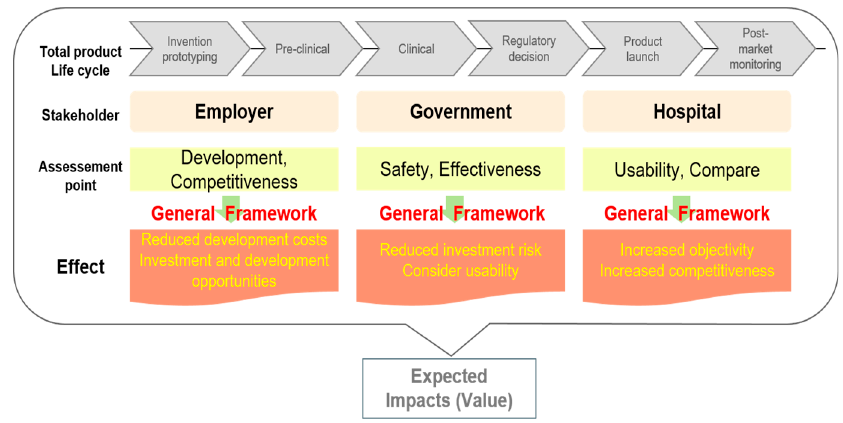
Figure 1. Effectiveness model of evaluation framework for each stakeholder. Figure 1. E ff ectiveness model of evaluation framework for each